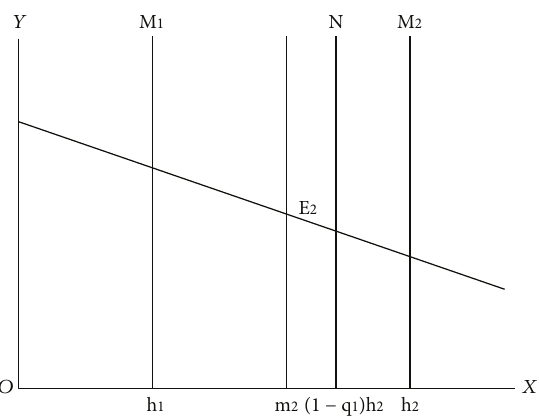
Figure 4: The case of h